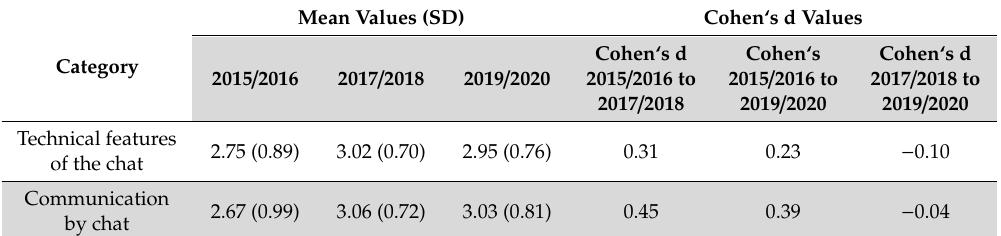
Table 3. Mean Value Comparison of Chat Function Assessment Using Cohen’s d (Cohen